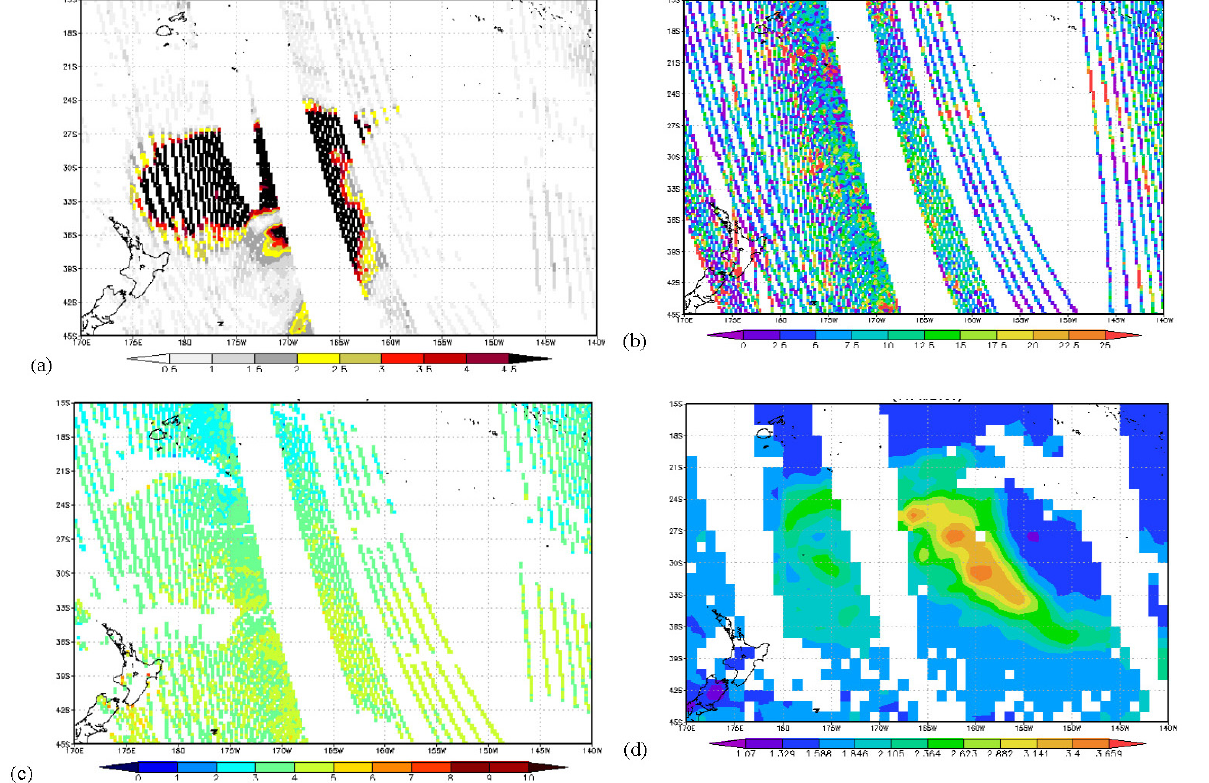
Figure 3. Images representing the travelling plume from Black Saturday from 15°S, 170°E to 45°S, 140°W on 9 February 2009 using ( a ) OMI UV aerosol index, ( b ) OMI H column amount (×10 15 molecules.cm − 2 ), ( c ) OMI NO (×10 15 molecules.cm − 2 ) and ( d ) AIRS CO total column amount (×10 18 molecules.cm − 2